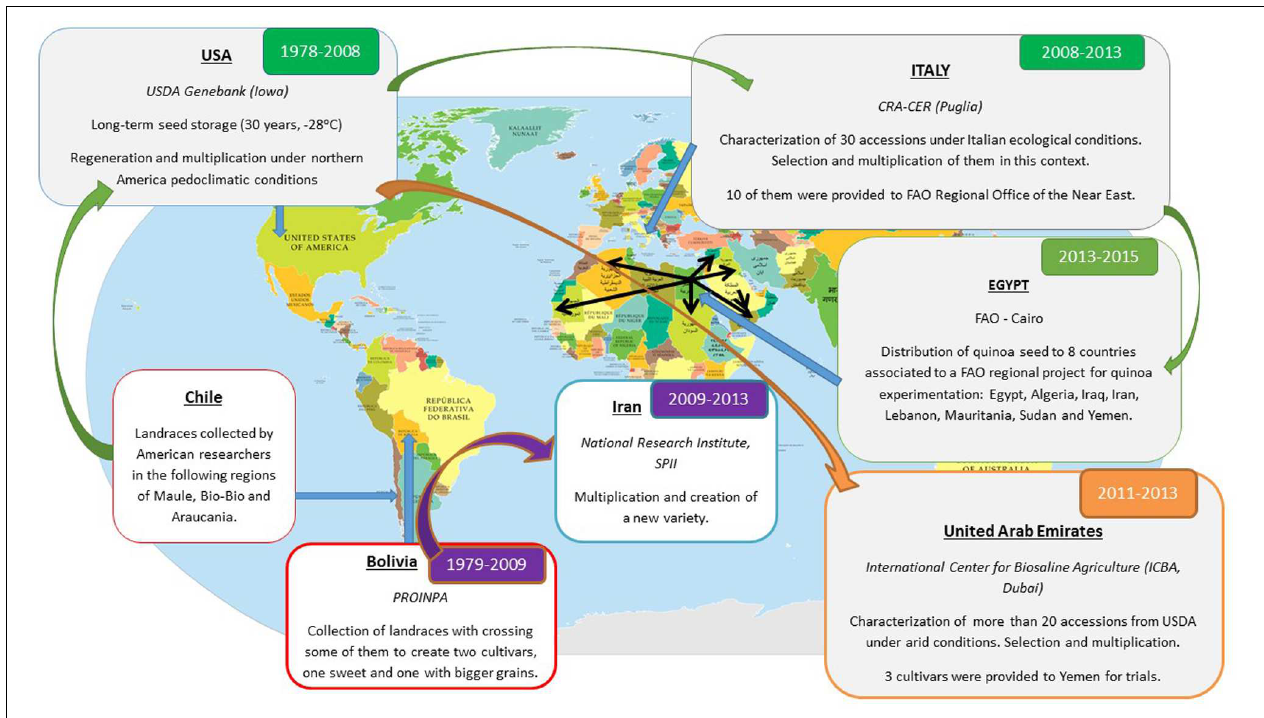
FIGURE 2 | An example of quinoa seed exchanges from Andean countries to new producers’